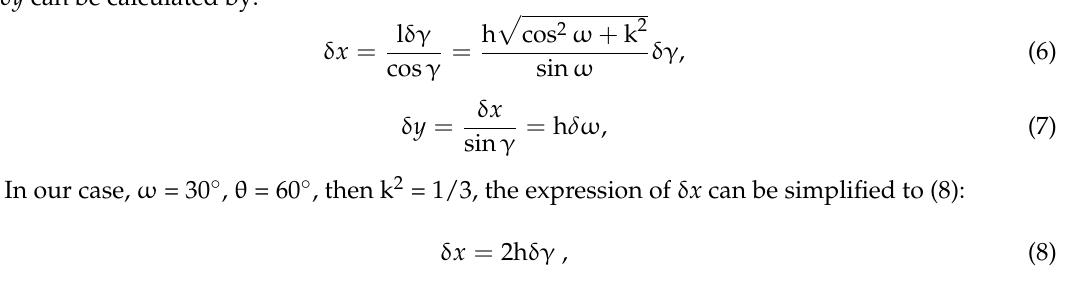
Figure 9. The results of the geo-registration process, the models of the roads and the buildings are matched well with the objects in the real image. ( Left ) The geo-registration process of roads and multiple buildings. ( Right ) The geo-registration process of separate large building.